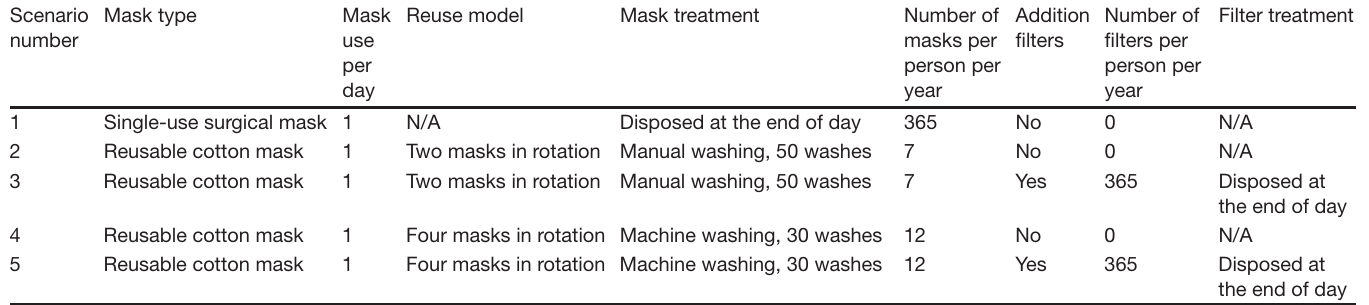
Table A2. Summary of scenarios compared in the comparative study. Scenario